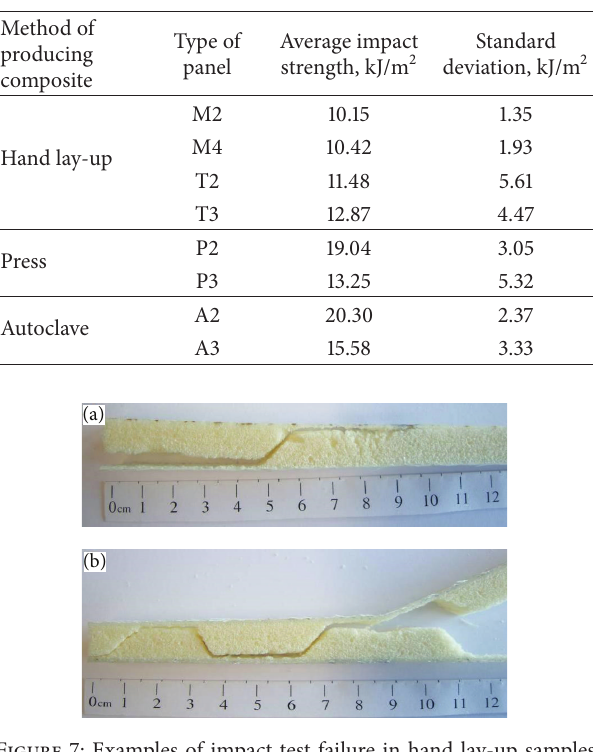
Figure 7: Examples of impact test failure in hand lay-up samples reinforced with (a) STR 015-300-110 fabric and (b) EM 1002/300/125 mat.